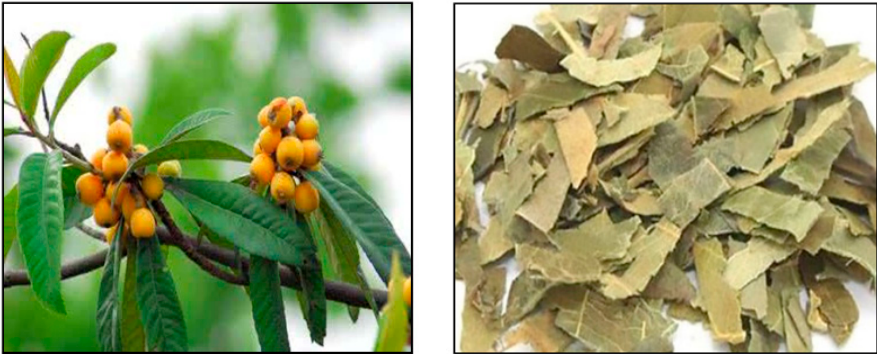
Figure 1. Loquat ( Eriobotrya Japonica (Thunb.) Lindl) and loquat leaves.